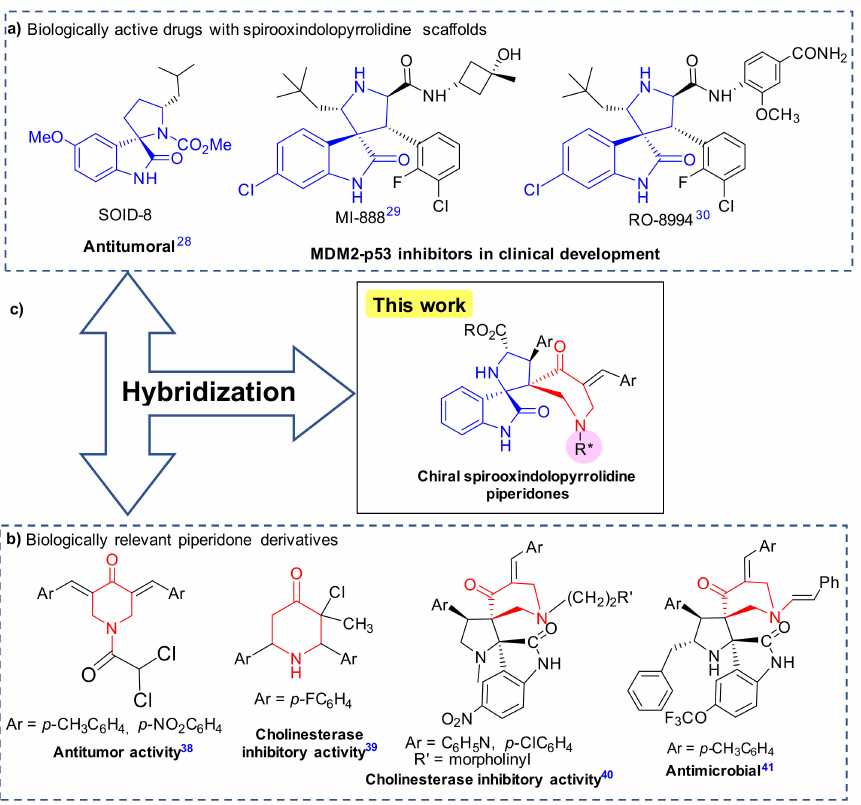
Figure 1. ( a ) Biologically relevant spirooxindolopyrrolidine derivatives; ( b ) Biologically active piperidone scaffolds; ( c ) Our target chiral spiroheterocycles combining the two